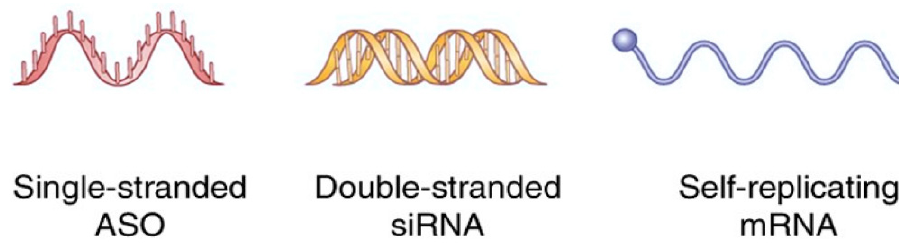
Figure 1. Main RNA used for cancer Figure 1 . Main RNA used for cancer therapy.